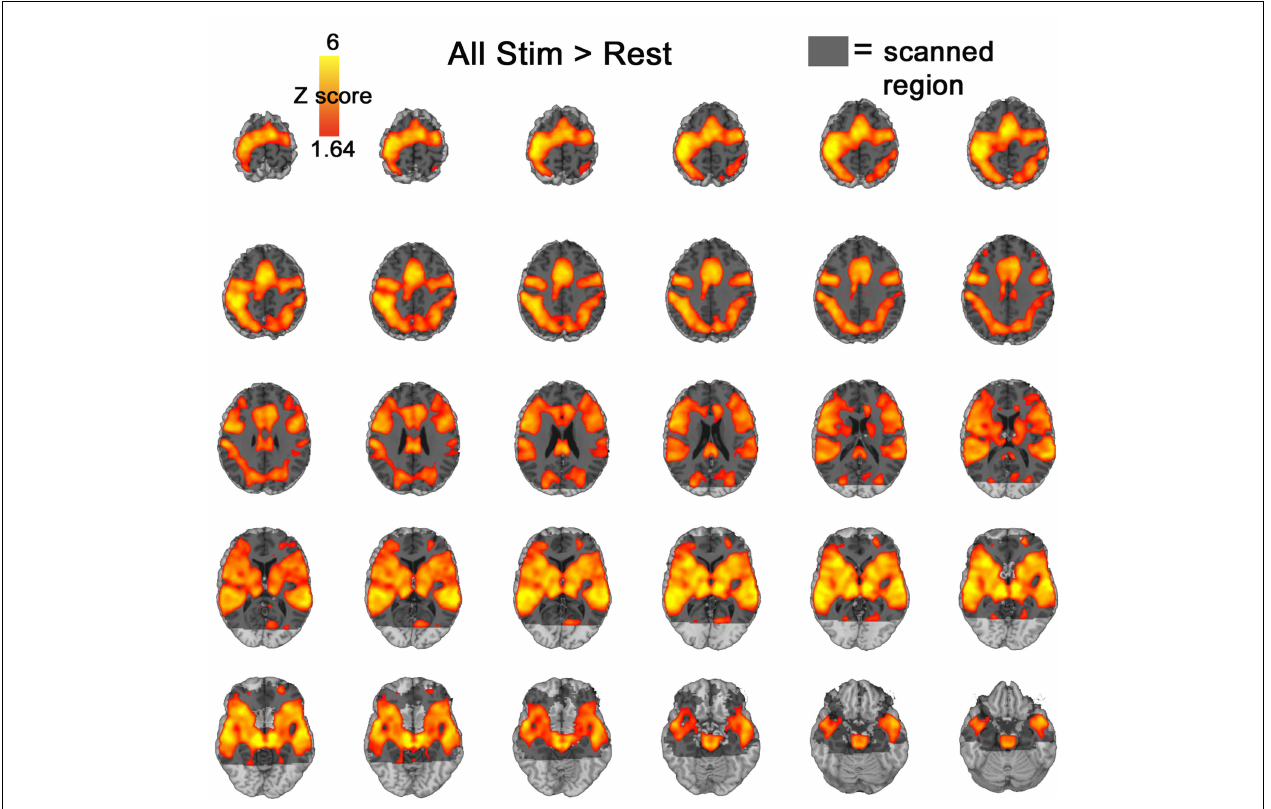
FIGURE 2 | All stimuli > rest. Activation presented at an uncorrected p < 0.05 threshhold. Grey shadow represents scanned regions of the